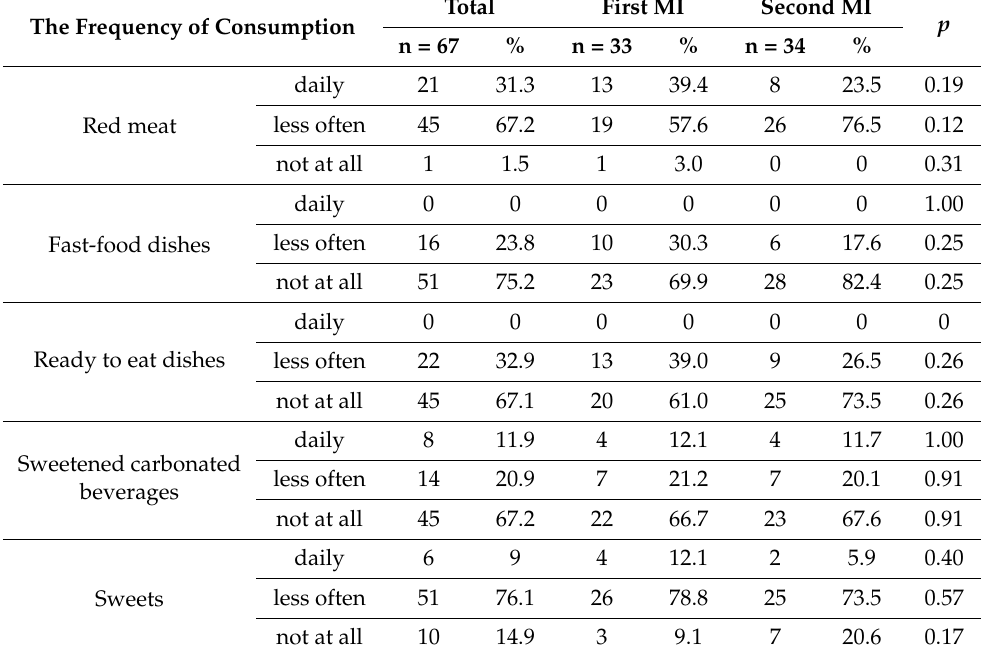
Table 5. Consumption rates for food products not recommended in the study group of patients in total and by MI history (n =